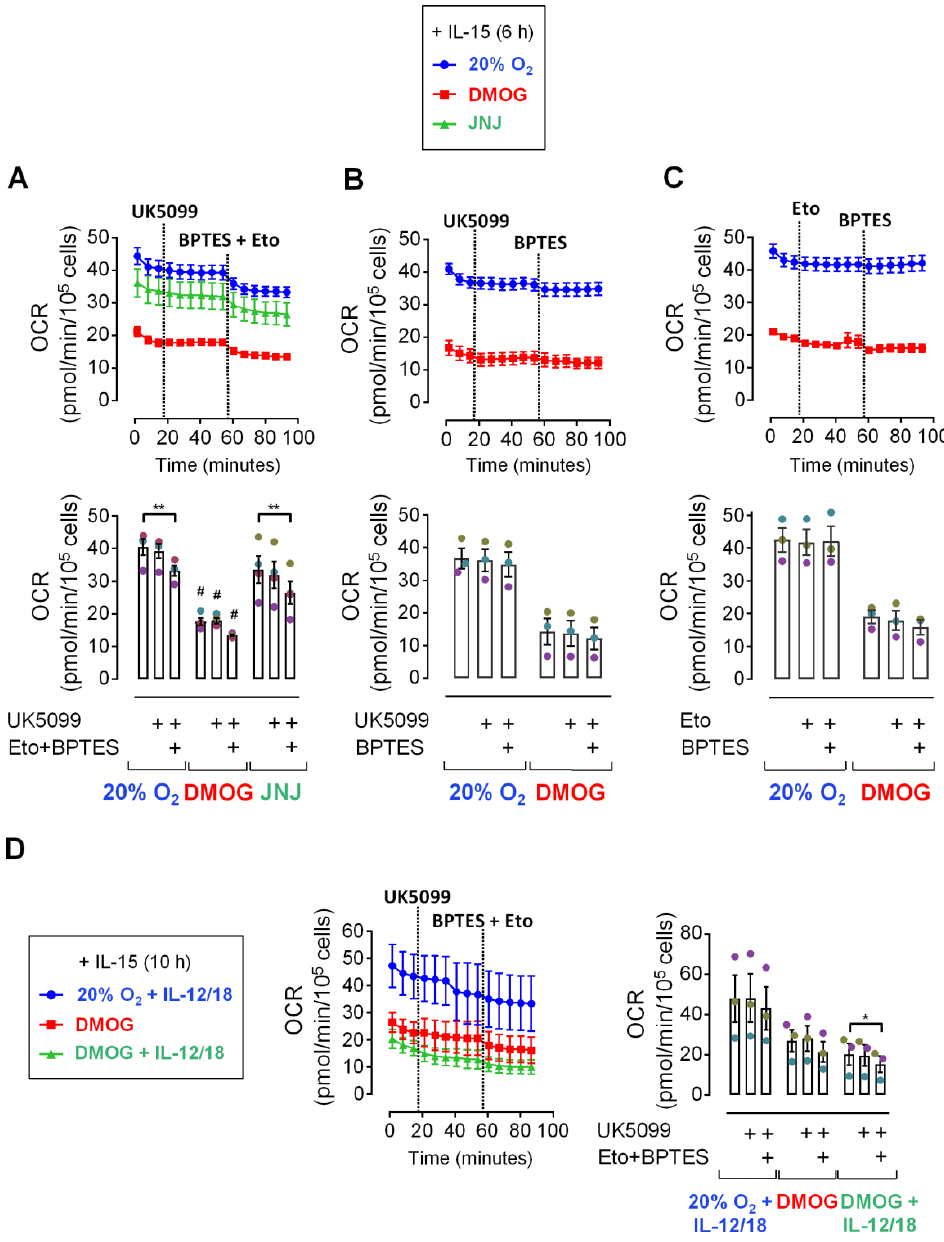
Figure 3. Carbon fuel dependency of oxygen consumption in primed human NK cells. ( A – C ) NK cells from 3 or 4 donors were cultured under normoxia (20% O 2 ) in the absence or presence of DMOG or JNJ. After 16 h, cells were primed with IL-15 for 6 h (legend on top). Oxygen consumption rate (OCR) values were subsequently acquired over time in the continued presence of IL-15 and with or without chemical hypoxia. The first three measurements were performed under basal conditions followed by the sequential injections of the MPC inhibitor UK5099 (2 µM), the GLS inhibitor BPTES (3 µM) and the CPT1A inhibitor etomoxir (4 µM). In panel ( D ), NK cells were IL-15 primed as in ( A – C ) and were cultured for another 4 h in the continued presence of IL-15 and chemical hypoxia and additionally IL-12 and IL-18 (legend to the left). Respective culture conditions were maintained during OCR measurements. The upper parts of panels ( A – C ) and the left part of ( D ) show OCR traces based on averaged biological replicates ± SEM with inhibitor injections indicated by dotted lines. The lower ( A – C ) or right ( D ) part of these panels displays the last recording before the first injection (baseline) and before the second injection (with first inhibitor) as well as the last recording (with all inhibitors) for the culture conditions indicated below the diagram. Data is shown as mean values ± SEM (bars) and scatter plots in a muted color scheme to identify data from same donors, i.e., independent experiments. Statistical significance of mean differences was determined with the Friedman test with